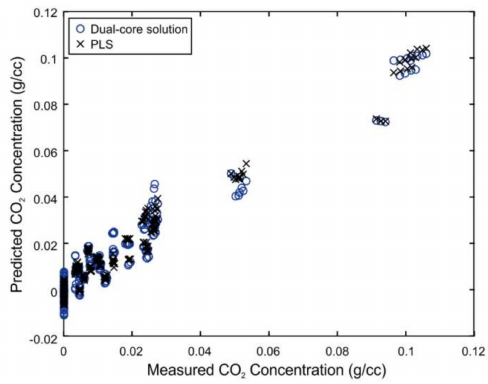
Figure 5. Comparison of predicted results between the dual-core optimized design and